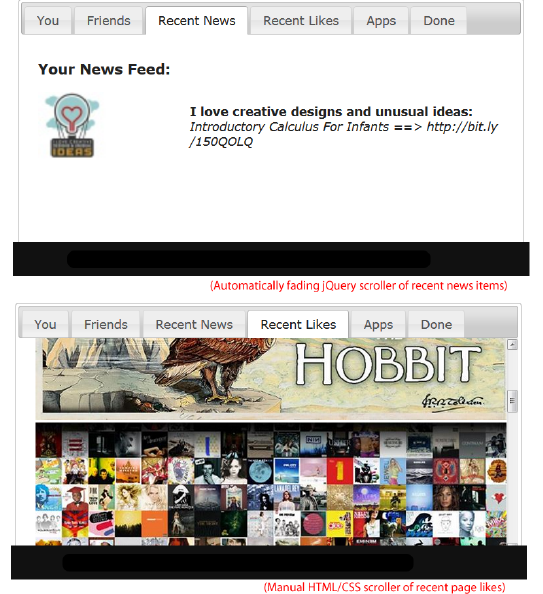
Figure 3. The interface of the Facebook Data